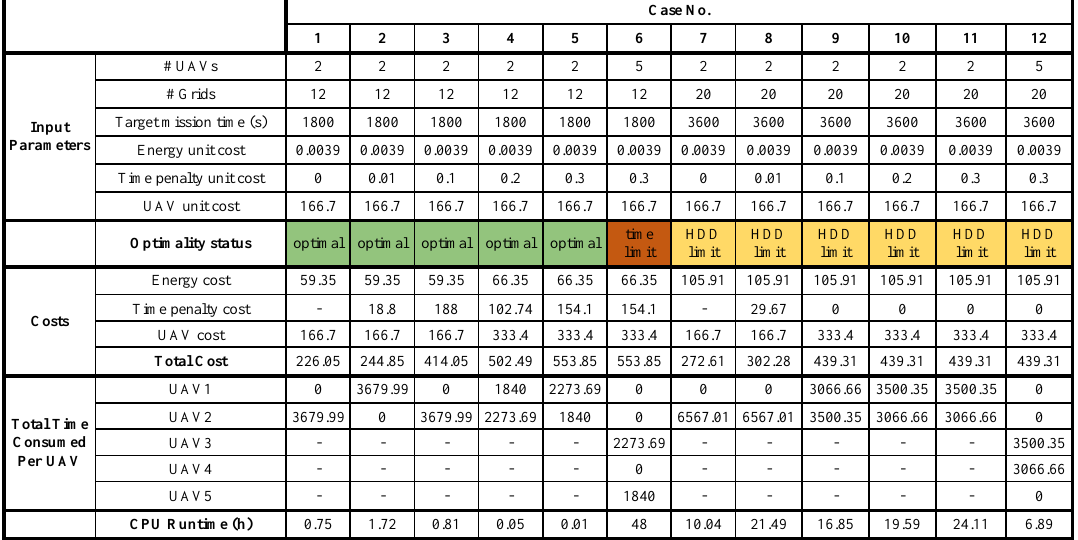
Table 6. Results on the grid problems with two maximum allowed trips and one round.